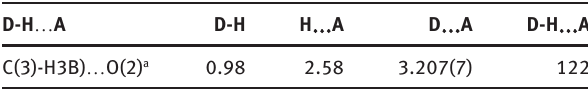
Table 3: Significant intermolecular interactions (interatomic) dis- tance (Å) and bond angles ( ° ) in complex 1